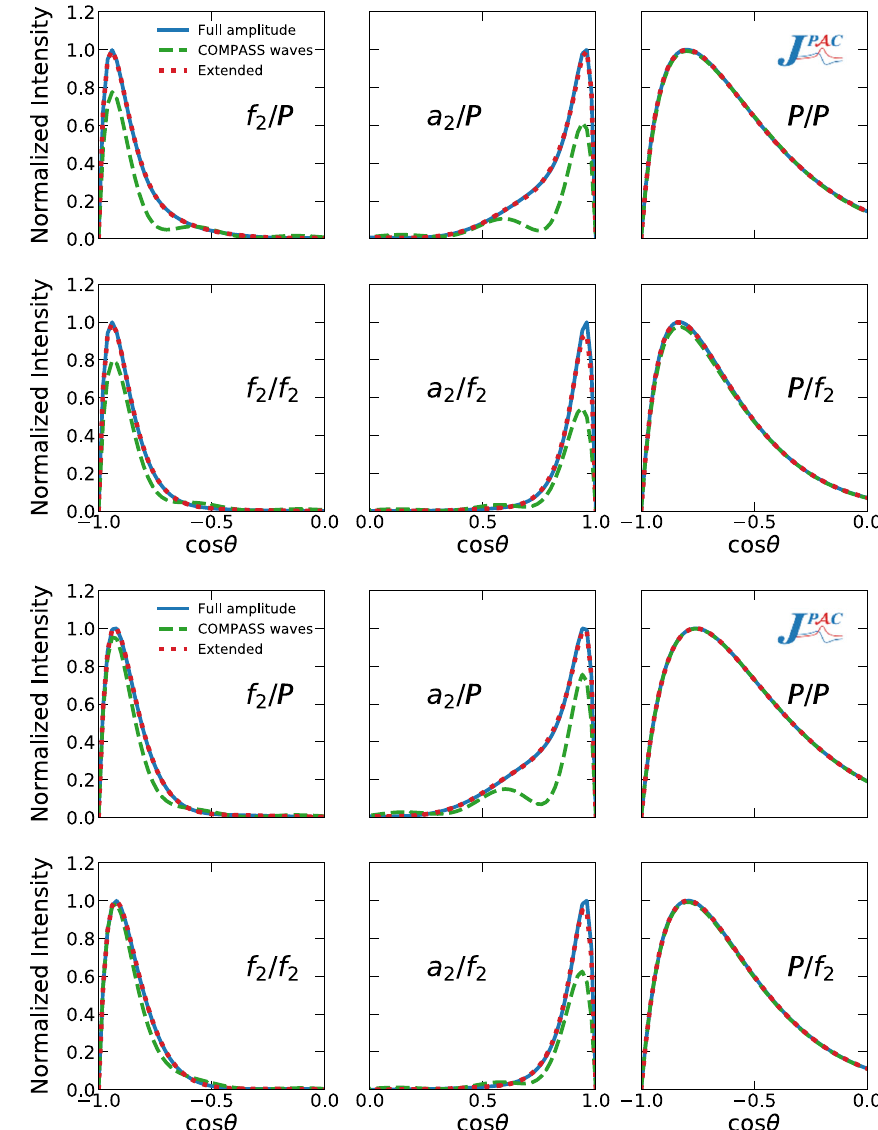
Fig. 6 I θ ( m ηπ , cos θ) for individual amplitudes at m ηπ = 2 . 64GeV for the ηπ channel. We compute the intensity of each individual amplitude (solid blue) normalized to its peak value. We compare it to two different partial wave truncations. The dashed green curve adds up the partial waves included in the COMPASS analysis, i.e. ( L ; M ) = ( 1 ,..., 6 ; 1 ) and ( 2 ; 2 ) . The dotted red curve is obtained by extending the sum to ( L ; M ) = ( 1 ,..., 10 ; 1 , 2 ) . One can appreciate that, while the COMPASS partial waves